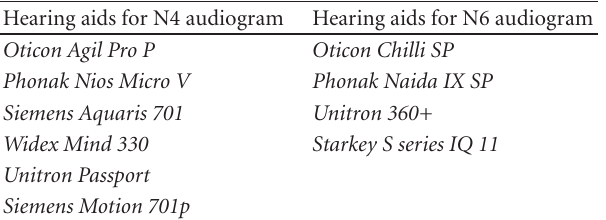
Hearing aids for N4 audiogram Hearing aids for N6